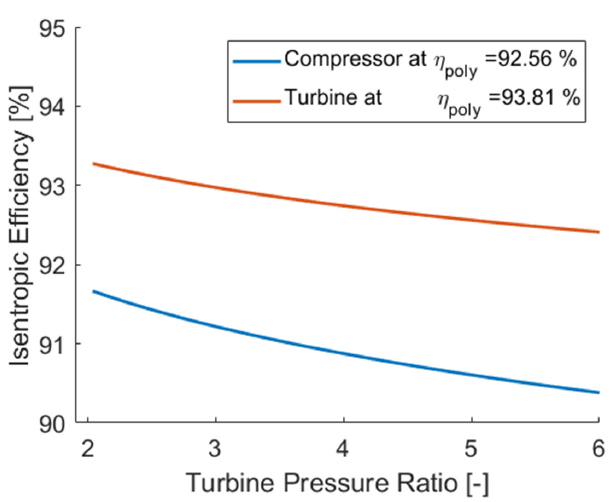
Figure 14. Isentropic efficiency of turbine and compressor of open-air Brayton Cycle.